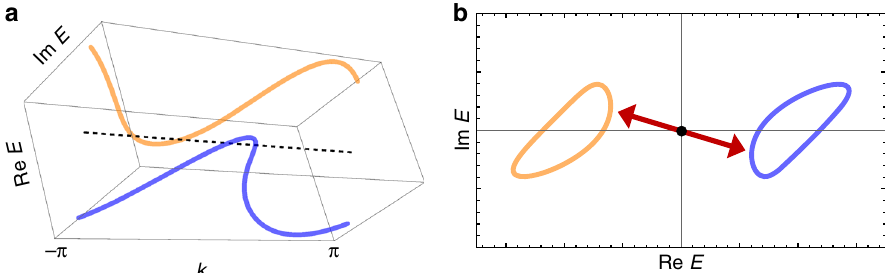
Fig. 1 Gapped band structure for a non-Hermitian Hamiltonian. Energy dispersion for two bands (blue and orange curves) in one dimension: a ( k , Re E , Im E ) with wavenumber k and complex energy E and b its projection on the complex energy plane (Re E , Im E ). The two bands neither touch nor intersect for any k , and therefore they are gapped. This de fi nition does not distinguish between real and imaginary parts of